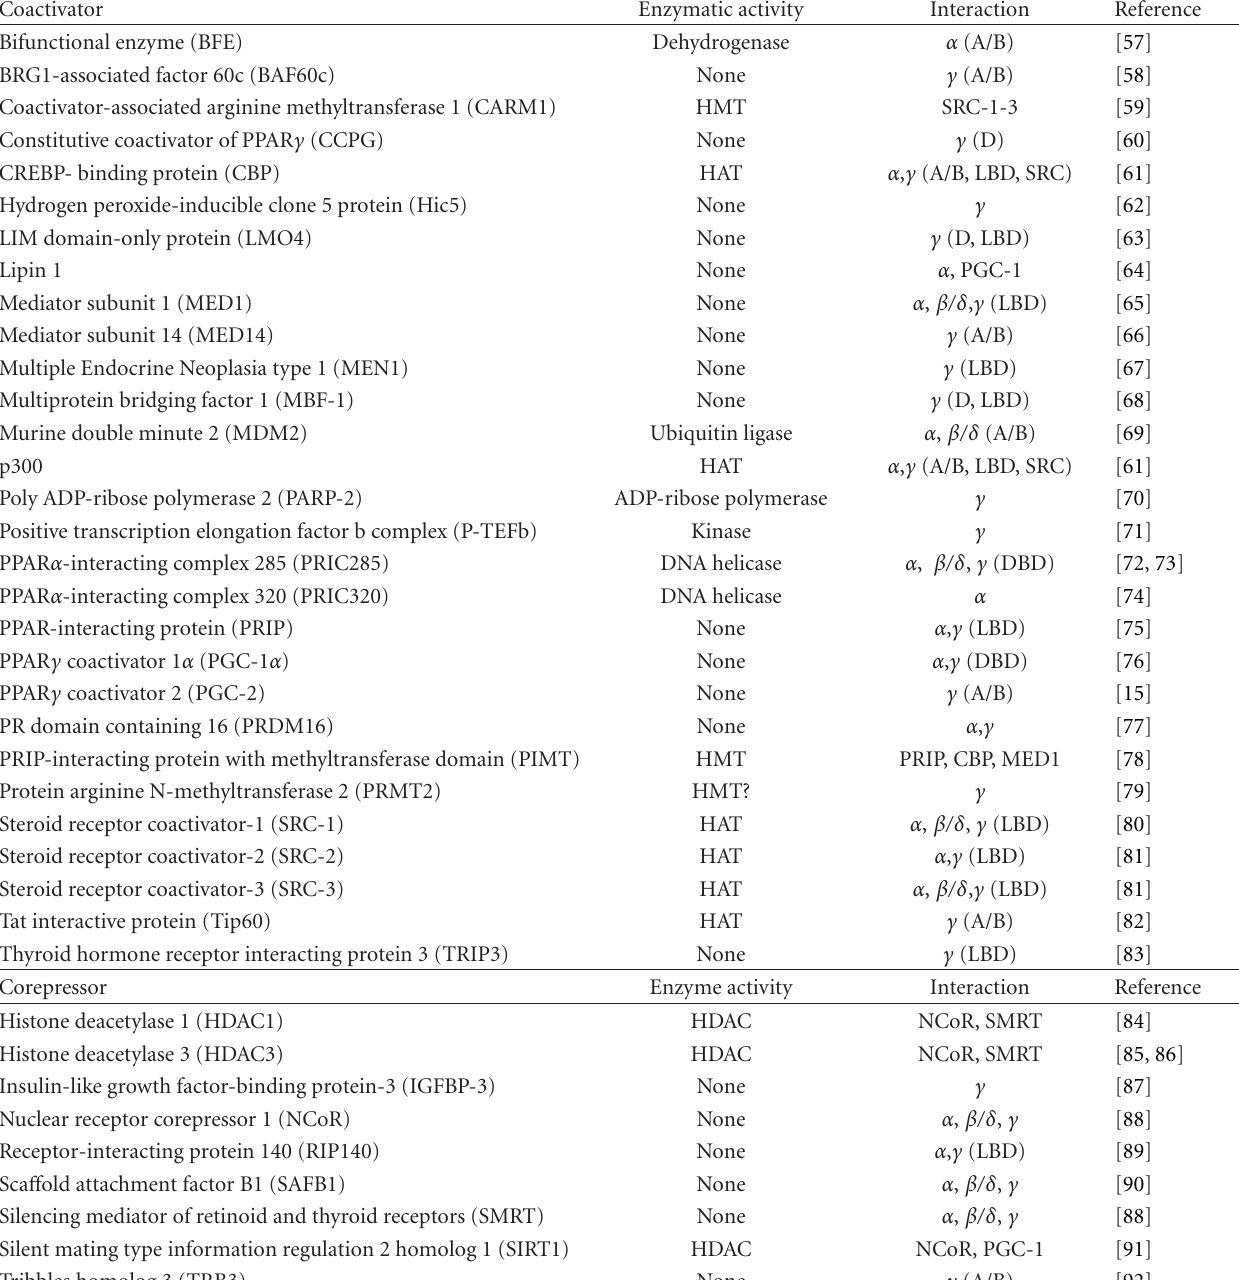
Table 1: Cofactors regulating PPAR